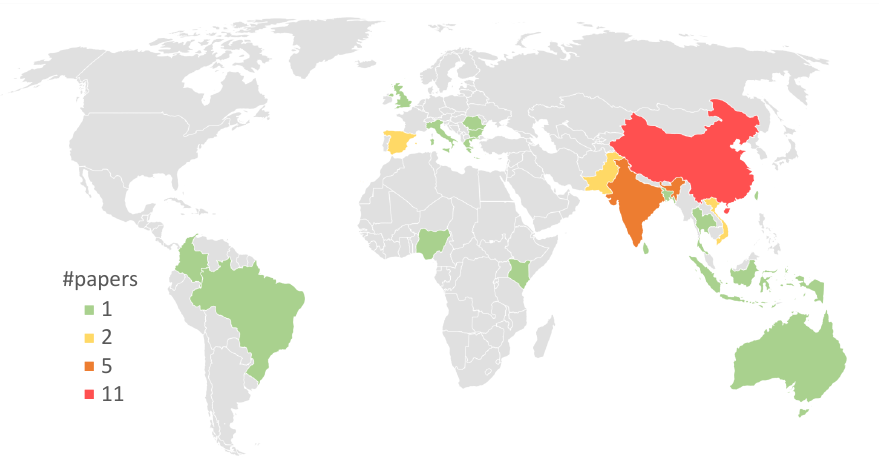
11 Figure 8. Countries for which the proposed solutions included in our scoping review were created or implemented.